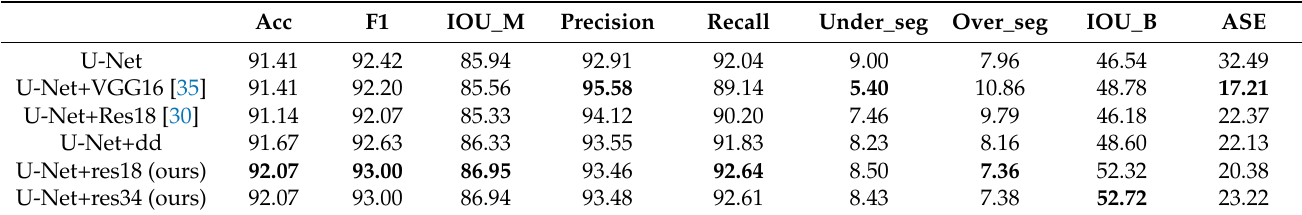
Table 3. Comparison among different encoders. The bold number means the best